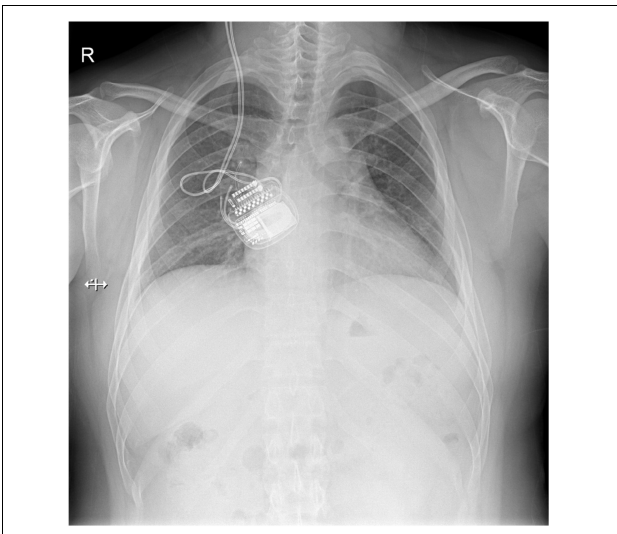
FIGURE 3 | Plain chest X-ray showing the normal view of the implanted pulse generator (IPG) and the extension wire. No fracturing or twisting of the wire was observed and the IPG was in the correct orientation.